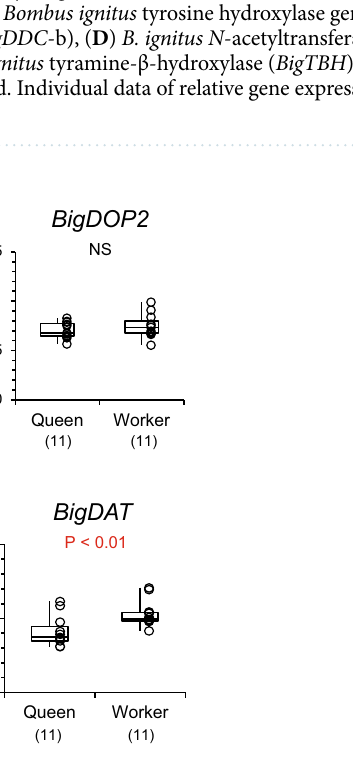
Figure 6. Relative expression levels of dopamine receptor genes and a dopamine transporter gene analyzed by qPCR. ( A ) Bombus ignitus dopamine receptor 1 gene ( BigDOP1 ), ( B ) B. ignitus dopamine receptor 2 gene ( BigDOP2 ), ( C ) B. ignitus dopamine receptor 3 gene ( BigDOP3 ), ( D ) B. ignitus dopamine transporter gene ( BigDAT ). Numbers in parentheses indicate the number of samples examined. Individual data of relative gene expression levels were indicated by plots in graphs and in Table